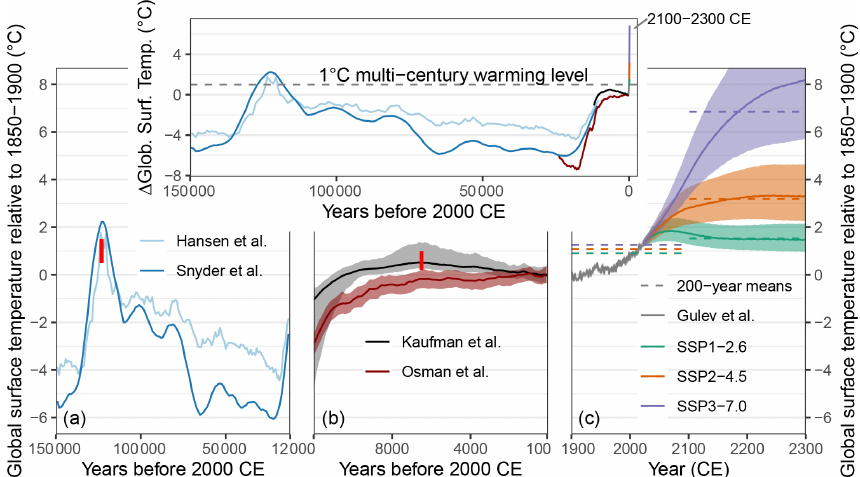
Figure 1. Global surface temperature over 150000 years relative to 1850–1900. Three timescales are shown according to their published resolutions: (a) 150000 to 12000 years ago based on marine oxygen isotopes in foraminifera (Hansen et al., 2013; Snyder, 2016), (b) 12000 years ago to 1900CE based on the Temp12k multi-method, multi-proxy ensemble reconstruction (Kaufman et al., 2020b) along with a post- AR6 reconstruction that blends marine proxy evidence with a climate model simulation (Osman et al., 2021a), and (c) 1900 to 2300 based on instrumental observations (gray line) (Gulev et al., 2021) and projections using three emissions scenarios (low, intermediate, and high) as assessed in AR6 (Lee et al., 2021). Horizontal dashed lines are 200-year averages (1900–2100, 2100–2300). Lines and shading in (b) and (c) show the ensemble mean and the 5%–95% range. Red bars in (a) and (b) are the IPCC-assessed (medium confidence; Gulev et al., 2021) temperature ranges from proxy evidence for the warmest intervals of the last interglacial (around 125000 years ago, 0.5–1.5 ◦ C) and Holocene (around 6500 years ago, 0.2–1 ◦ C). These values are based on multiple studies, including the time series displayed here. The inset shows all three panels on the same timescale with 200-year resolution so that the past, present, and future are directly comparable. See the “Code and data availability” section for details on data sources and adjustments used to align temperature changes relative to the 1850–1900 reference